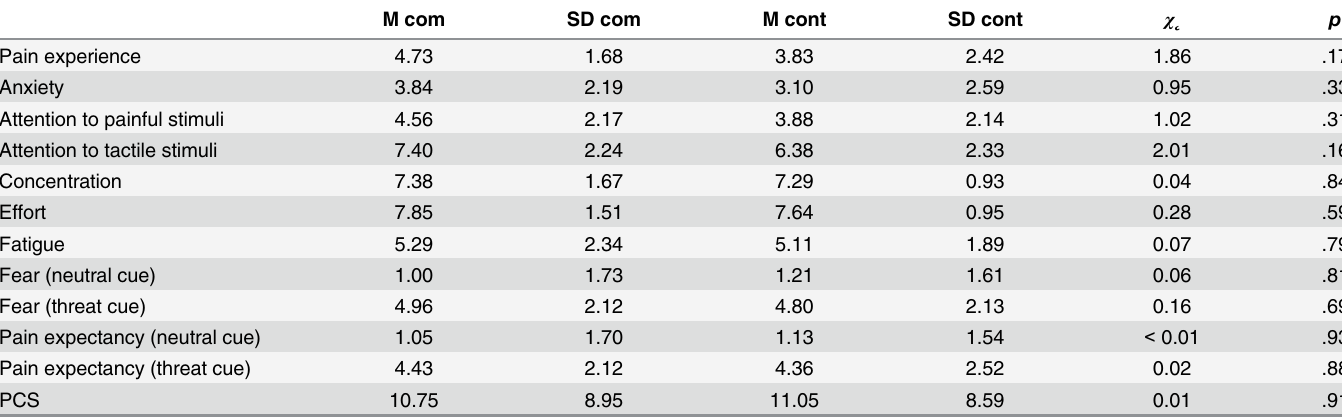
Table 2. Self report data.